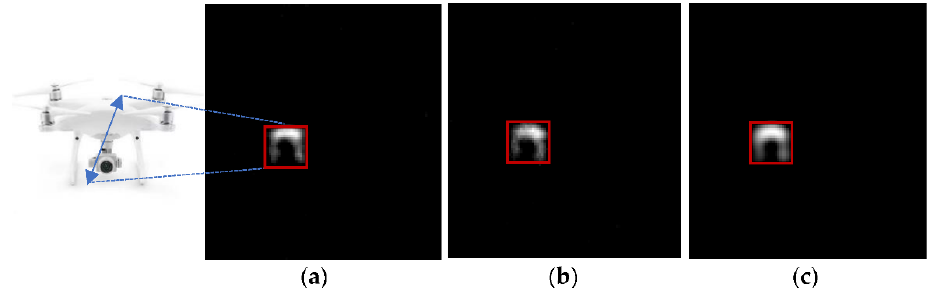
Figure 14. Comparison of imaging effects of a dual-FSM 3D GISC LiDAR system under the control of digital decoupling and resonance suppression at different Speeds of a UAV ( a ) UAV hovering; ( b ) UAV V = 2 m/s; ( c ) UAV V = 7 m/s.